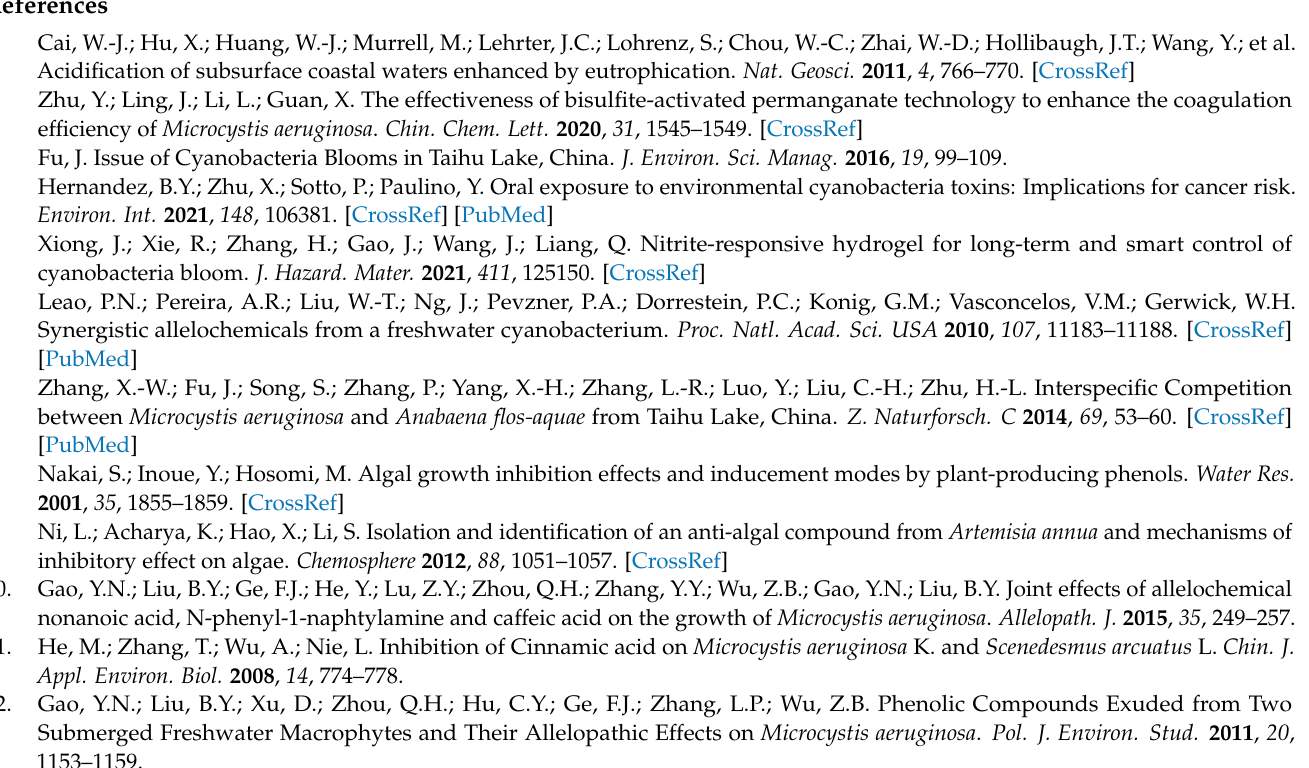
Table S1: Predicted and experimental pEC 50 values of 3D-QSAR